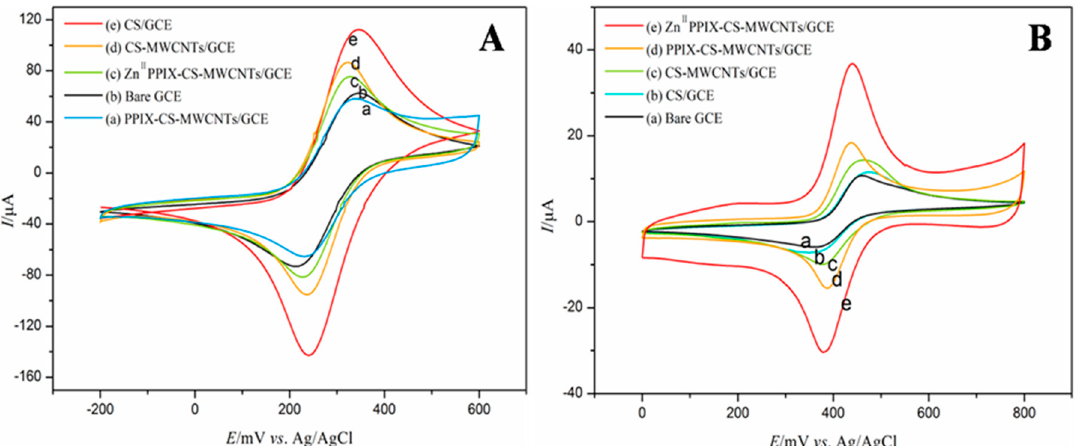
Figure 4. ( A ) Cyclic voltammograms of bare GCE ( a ), PPIX–CS–MWCNTs ( b ), Zn–PPIX–CS– MWCNTs ( c ), CS–MWCNTs ( d ), and CS (e) –modified GC electrode recorded in 0.1M KCl solution containing 10 mM [Fe(CN) 6 ] 3 − , scanning rate: 50 mVs − 1 . ( B ) Cyclic voltammograms of bare GCE ( a ), CS ( b ), CS–MWCNTs ( c ), PPIX–CS–MWCNTs ( d ), and Zn–PPIX–CS–MWCNT ( e ) –modified GC electrode in 0.05 M Na 2 HPO 4 –citric-acid solution (pH 4.0) containing 0.5 mM caffeic acid.